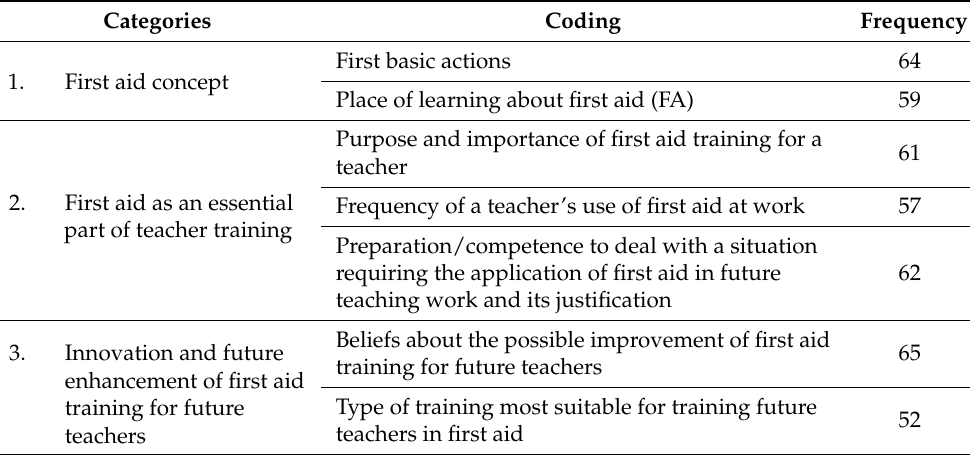
Table 1. Categorization system, coding, and